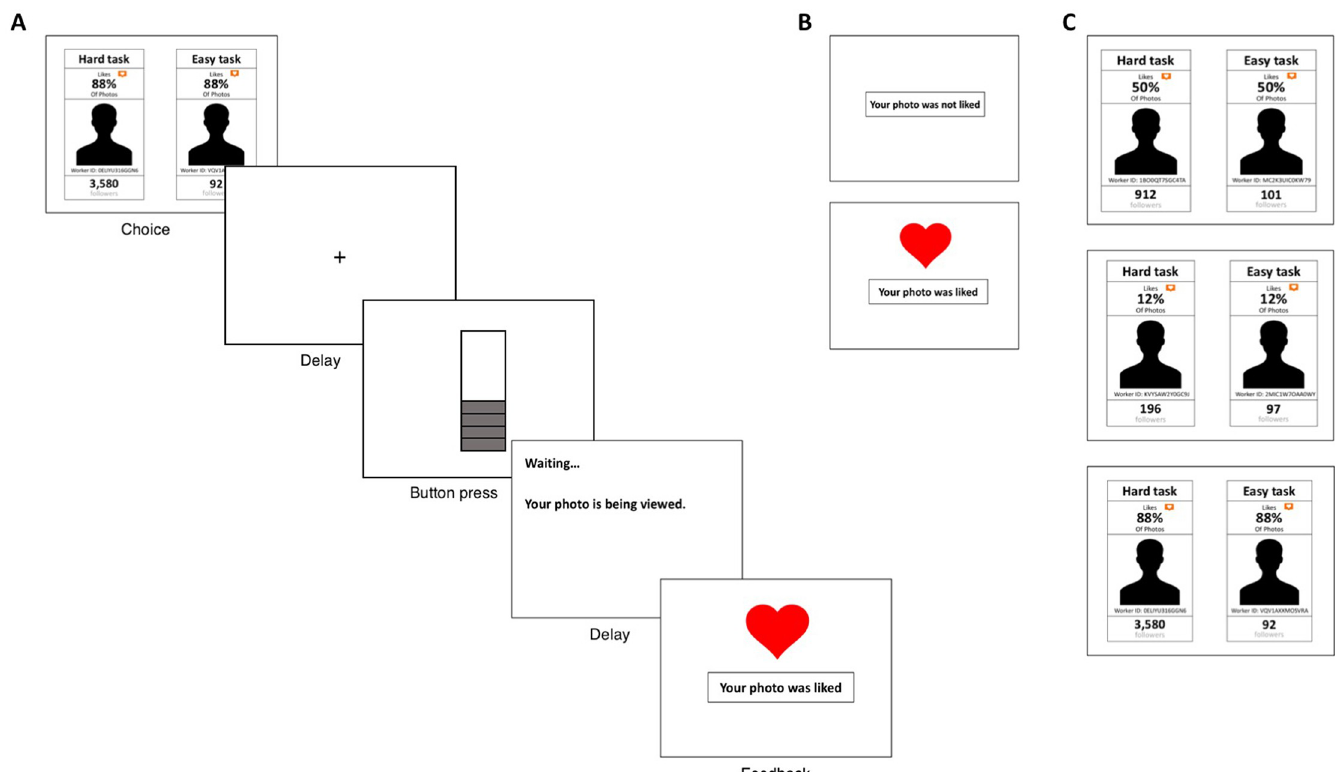
positive feedback (bottom). C) Three examples of task choices; 50% probability of a like (top), 12% probability of a like (middle), and 88% probability of a like